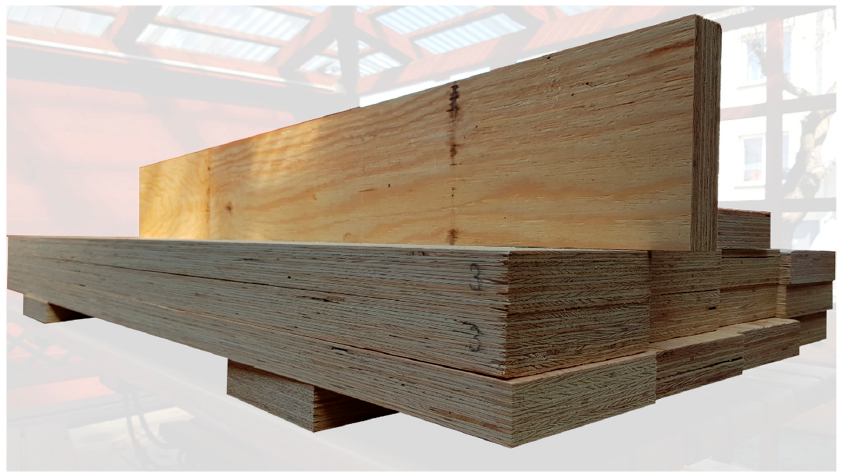
Figure 2. View of the LVL beams.